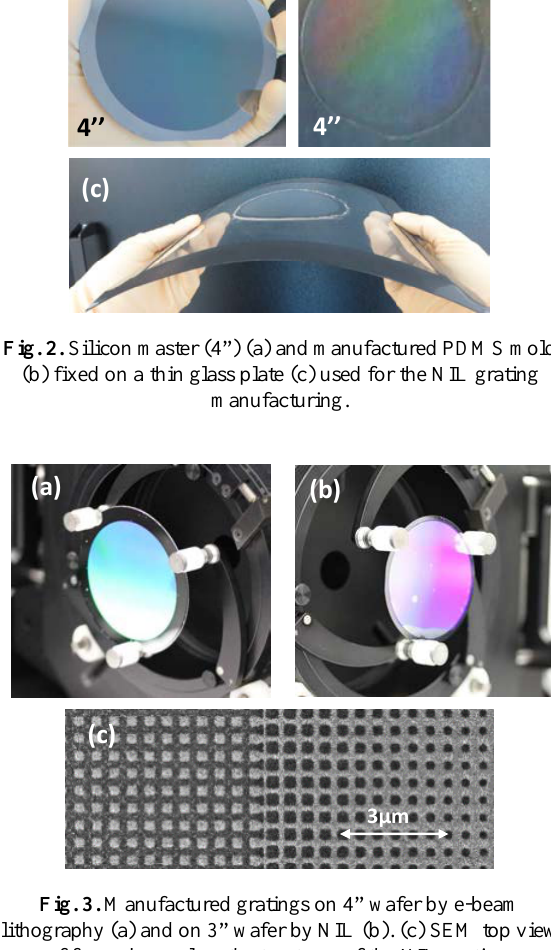
Fig. 1. Process flow for the realization of the gratings.